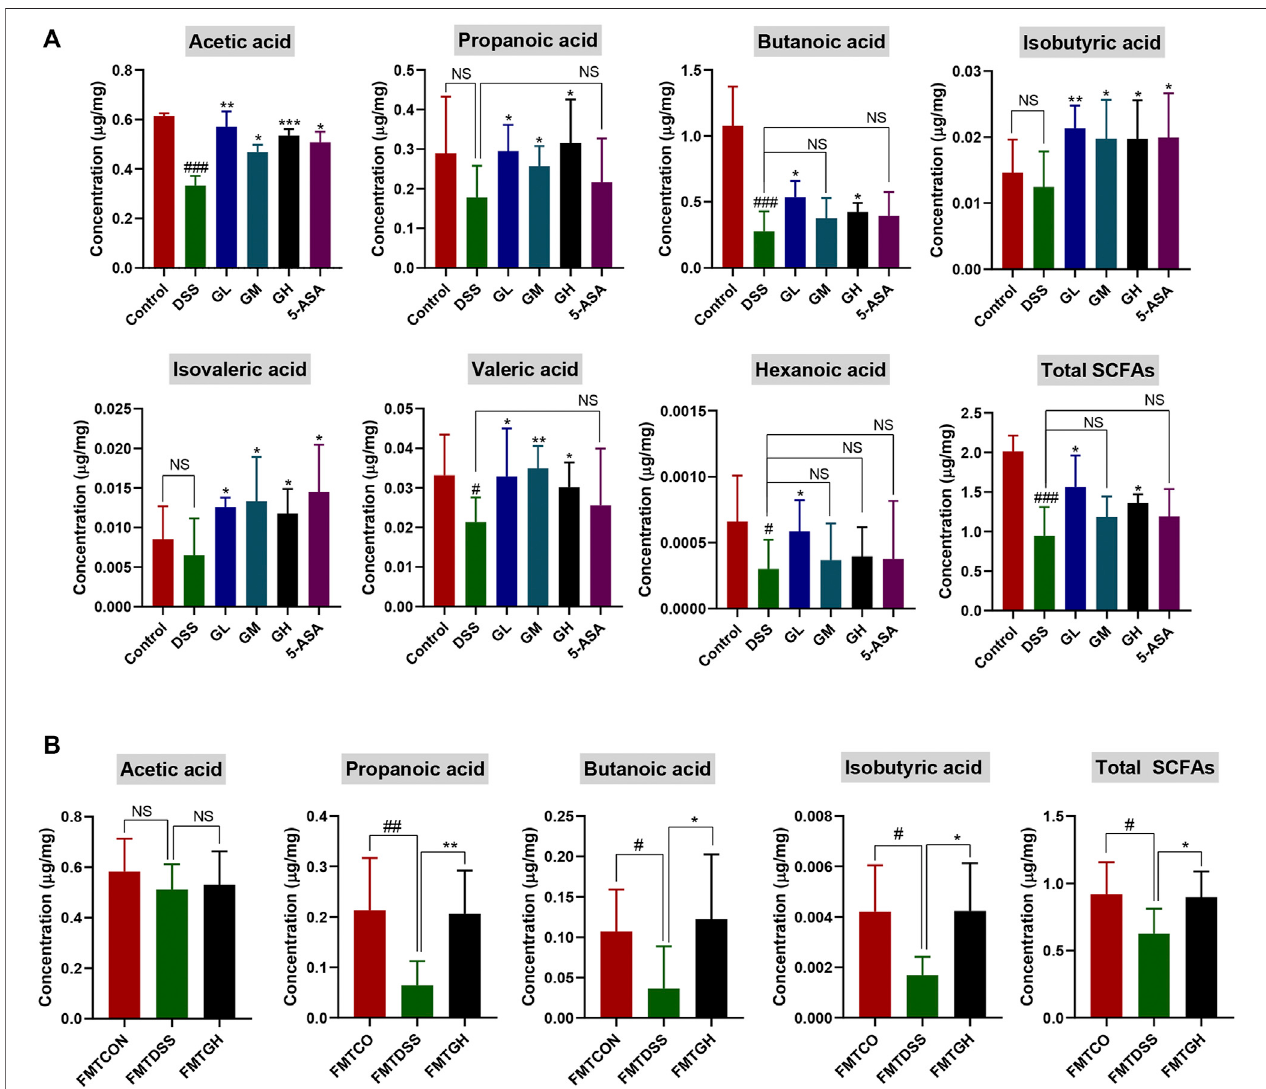
FIGURE 9 | MGQD treatment and FMT enhanced the content of microbial metabolites SCFAs in DSS-treated mice. (A) The concentration of SCFAs, including acetic acid, propanoic acid, butanoic acid, isobutyric acid, isovaleric acid, valeric acid, hexanoic acid and Total SCFAs in cecal contents among six groups. Results were shown as mean ± SD (n (cid:2) 5 – 9). # p < 0.05, ### p < 0.001, vs control group; * p < 0.05, ** p < 0.01, *** p < 0.001, vs DSS group. (B) The concentration of SCFAs, including acetic acid, propanoic acid, butanoic acid, isobutyric acid and Total SCFAs in cecal contents among FMT groups. Results were shown as mean ± SD (n (cid:2) 5 – 10). # p < 0.05, ## p < 0.01, vs FMTCON group; * p < 0.05, ** p < 0.01, vs FMTDSS group. NS means no statistical signi fi